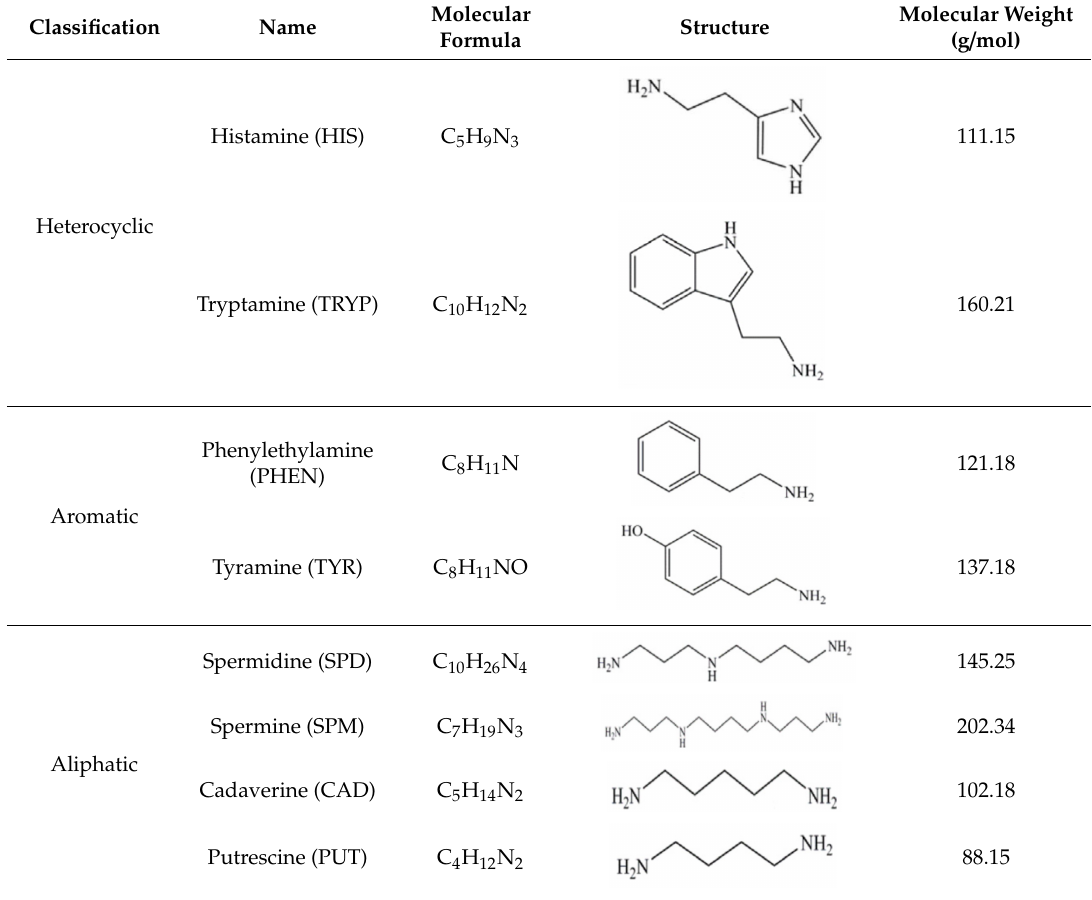
Table 1. Classification and basic information of the eight most common biogenic amines. Adapted from [52] with permission from